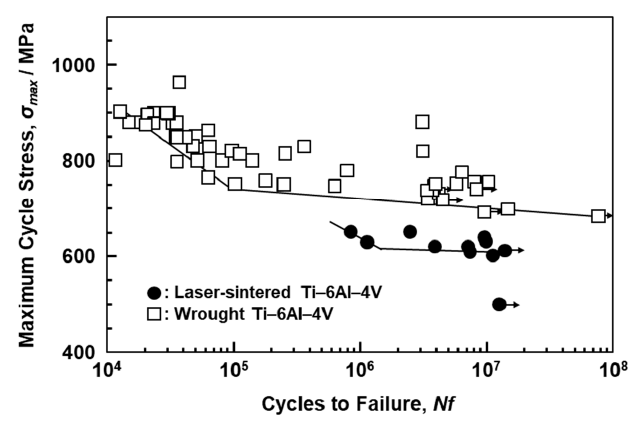
Figure11. S–Ncurvesofonce-sinteredTi-6Al-4Valloybuiltin90 ◦ Figure 11. S–N curves of once-sintered Ti-6Al-4V alloy built in 90° direction and wrought Ti-6Al-4V alloy.